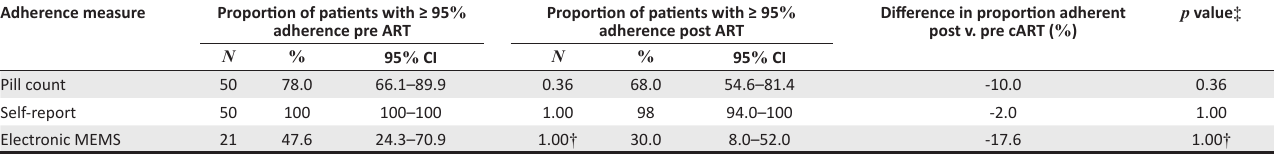
TABLE 2c: Ninety-five percent adherence to tuberculosis treatment before and after initiation of antiretroviral treatment. Adherence measure